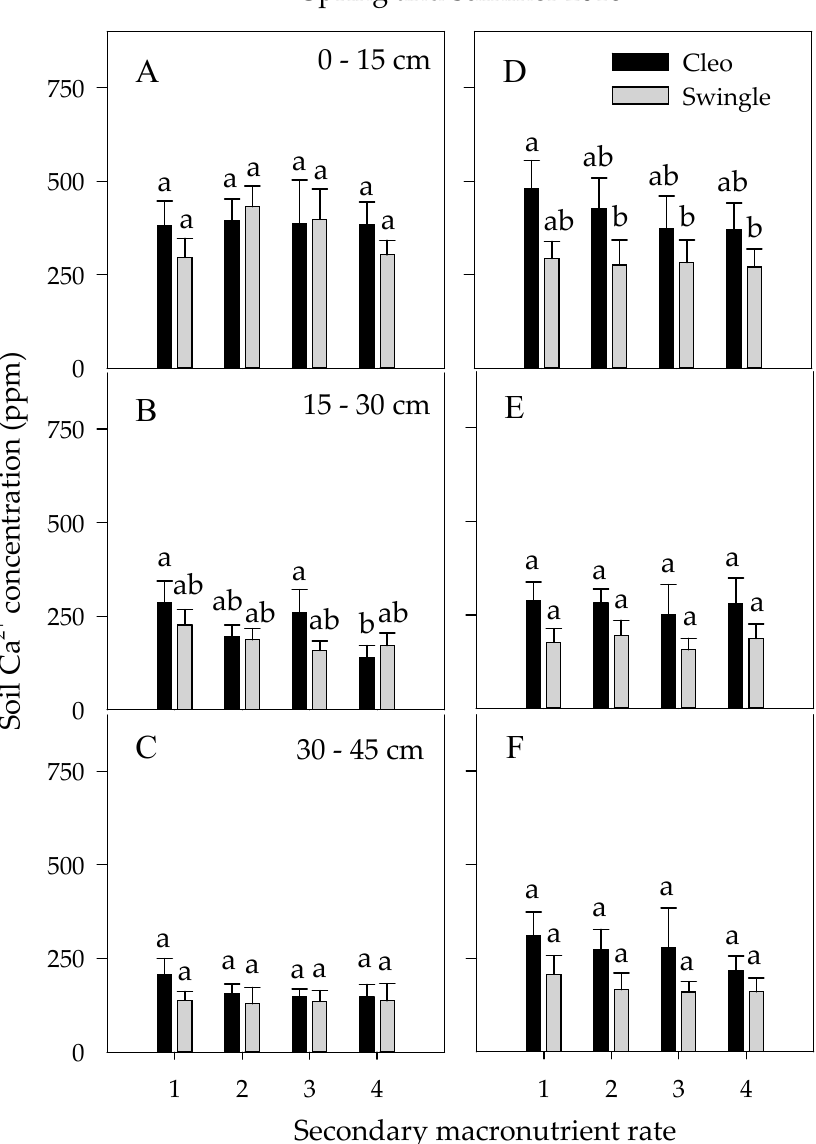
Figure 7. Soil Ca 2+ dynamics and accumulation of Huanglongbing (HLB)-affected Hamlin citrus trees budded on Cleo and Swc rootstocks during spring ( A – C ) and summer ( D – F ) 2018 in three soil depths (0–15, 15–30, and 30–45 cm). Treatments: Control (1), full Ca dose (2), full Mg dose (3), and half Ca and half Mg doses (4), (full dose = 45 kg ha − 1 ). Means with different lower case letters are significantly different at p ≤ 0.05, based on the Tukey–Kramer honestly significant difference test (n = 36).